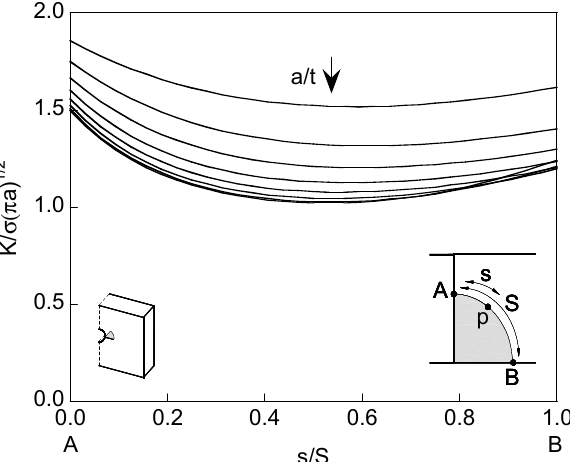
Figure 12. Dimensionless SIF along the crack front for the preferential fatigue propagation path (fatigue in air; cracks emanating from a hole with r = 0.5 t ).